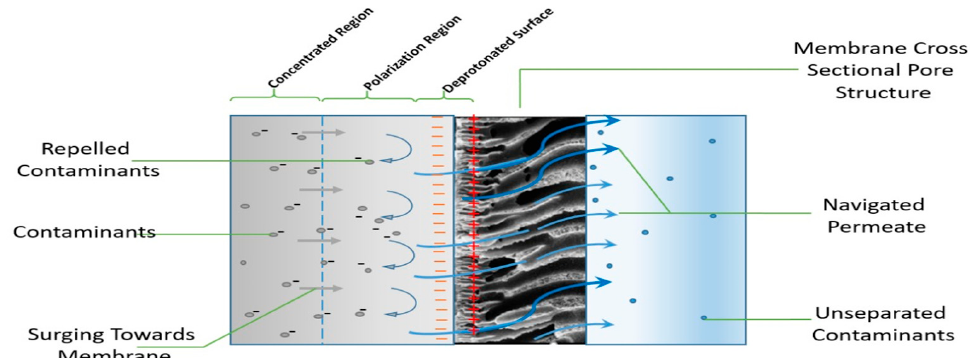
Figure 2. Removal mechanisms for EDCs during membrane processes via adsorption, sieving mechanism, and electrostatic interactions.